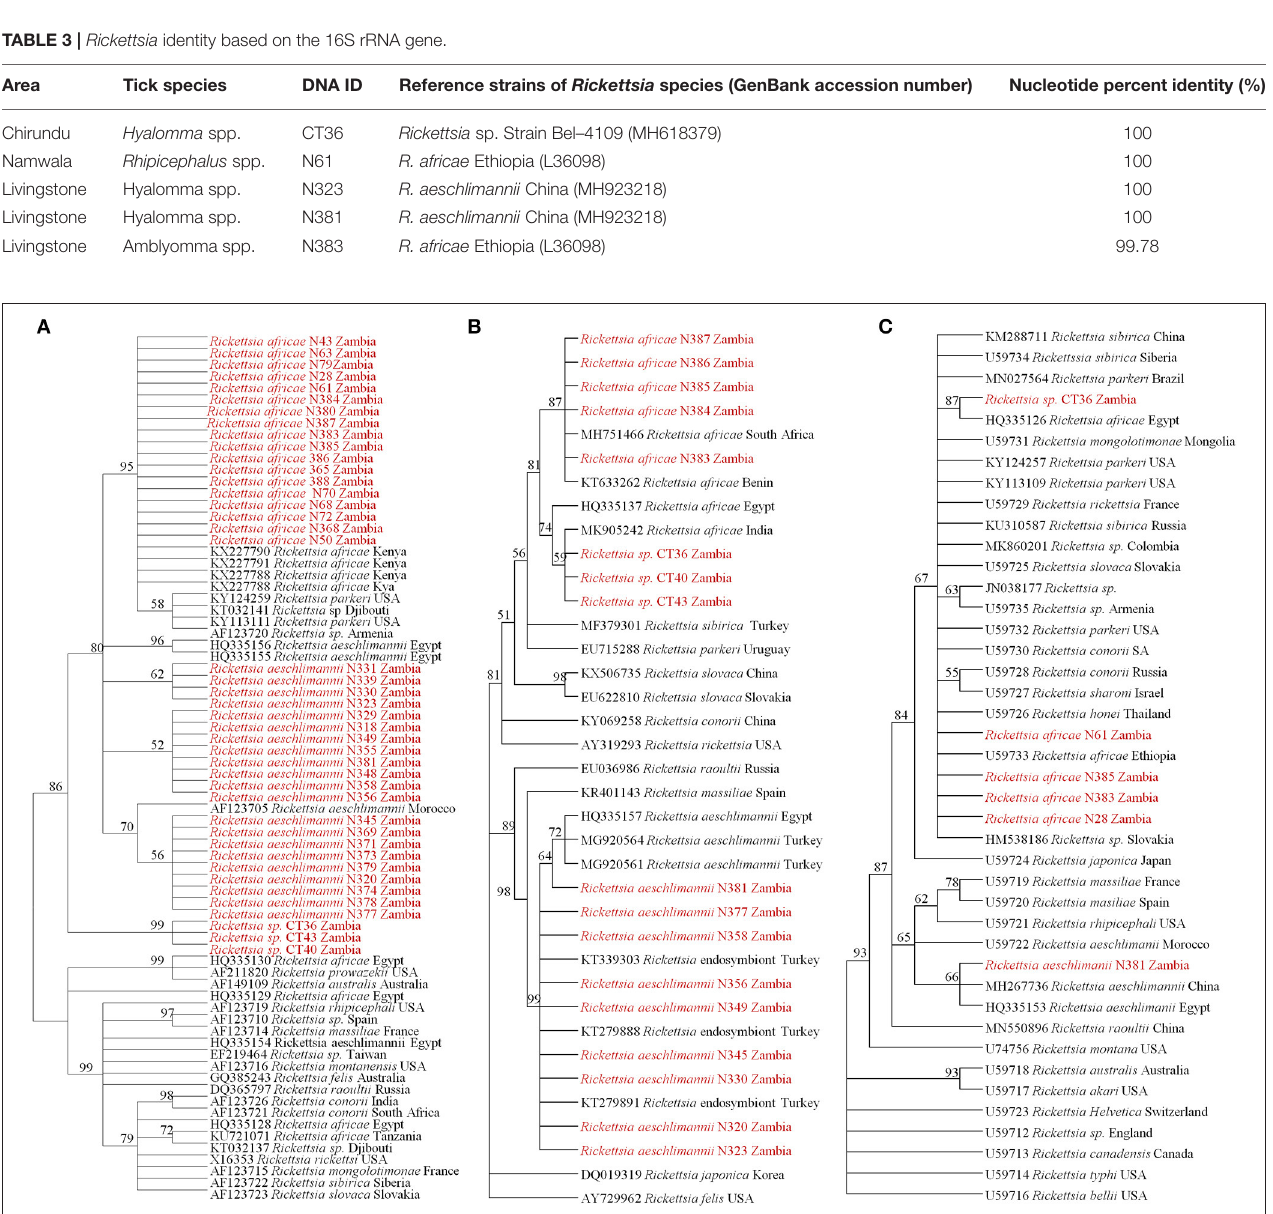
TABLE 3 | Rickettsia identity based on the 16S rRNA gene. Area